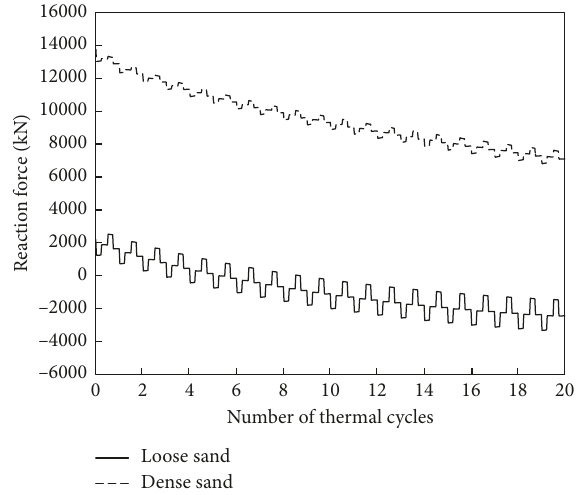
Figure 12: Variations in the reaction force for the restrained head pile.